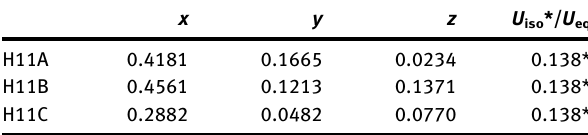
intermolecular N – H / N hydrogen bonding bonds. Adjacent dimers are connected with each other by N – H / O hydrogen bondsto constructa wideanionic ribbon.Consecutively,the wide ribbons are connected by water molecules to generate a 2-dimensional hydrogen-bonded layer. At last, tetraethy- lammonium cations are between the layers to form the typical sandwich-like crystal structure. Obviously, 1,3,5- thiadiazole-5-amido-2-carbamate can be regarded as a quali fi ed hydrogen-bond donor and acceptor due to its N – H and – COO groups.